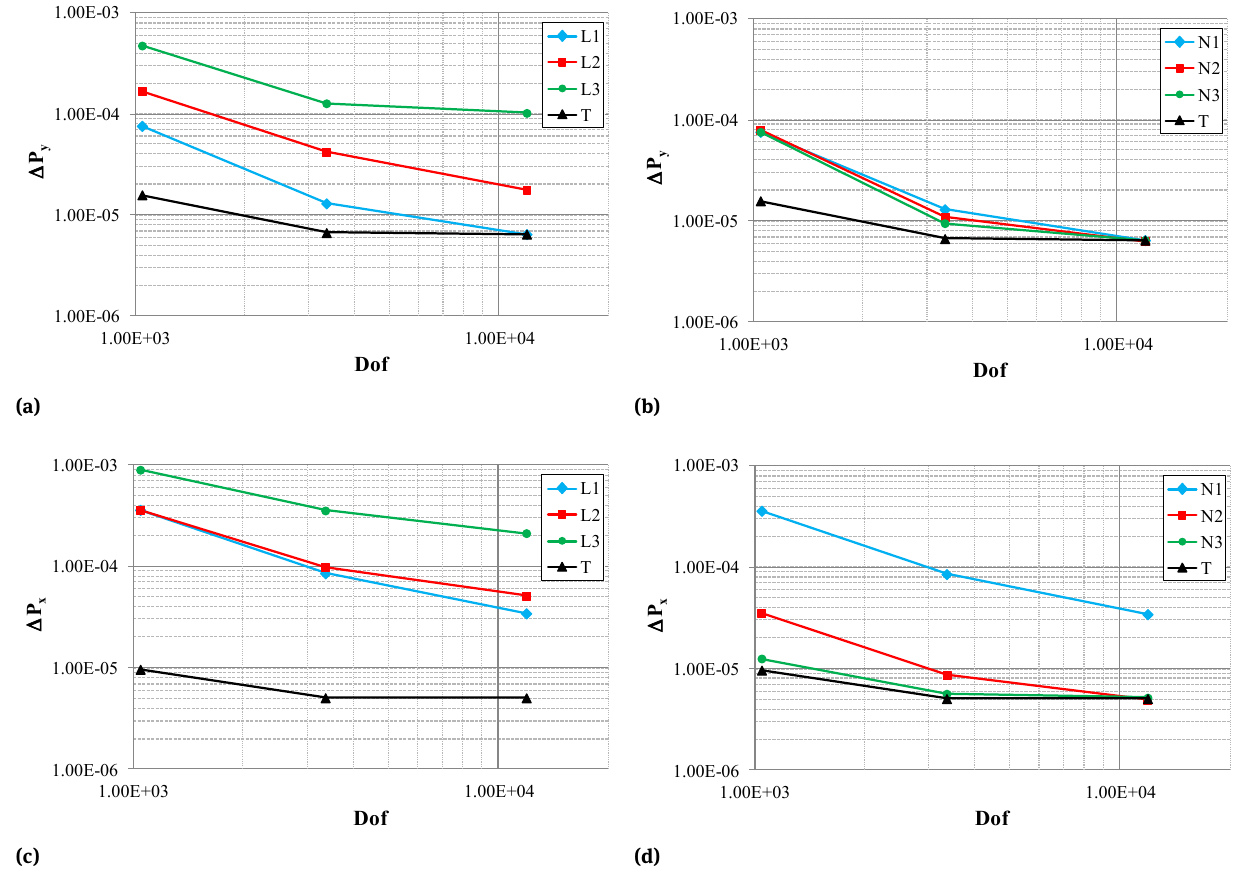
Figure 13: Ironing problem: amplitude of the vertical (a,b) and the horizontal (c,d) reaction forces for different